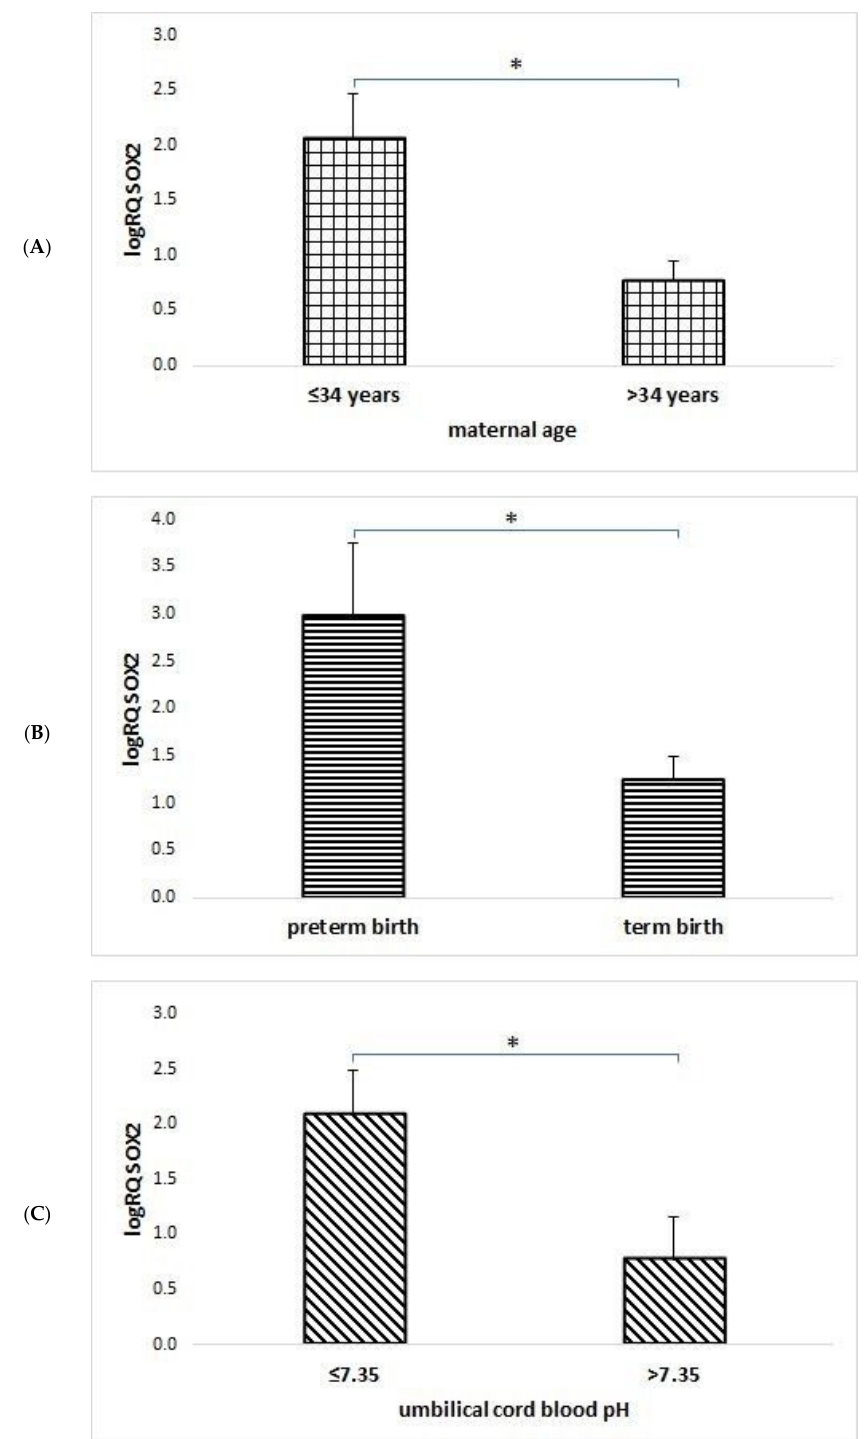
Figure 4. Average expression of SOX2 gene (logRQ ± SE) in WJSC ( A ). depending on the parturient’s age; ( B ). depending on delivery time; ( C ). depending on umbilical cord blood pH. * p < 0.05 U Mann Whitney test.